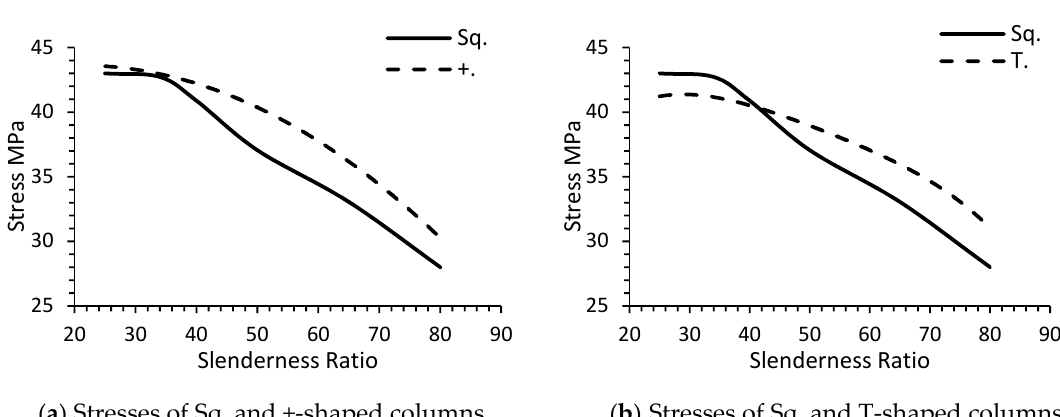
( a ) Stresses of Sq. and +-shaped columns ( b ) Stresses of Sq. and T-shaped columns Figure 10. Comparison of stresses between specially shaped reinforced concrete (SSRC) and square-shaped columns for different SR.